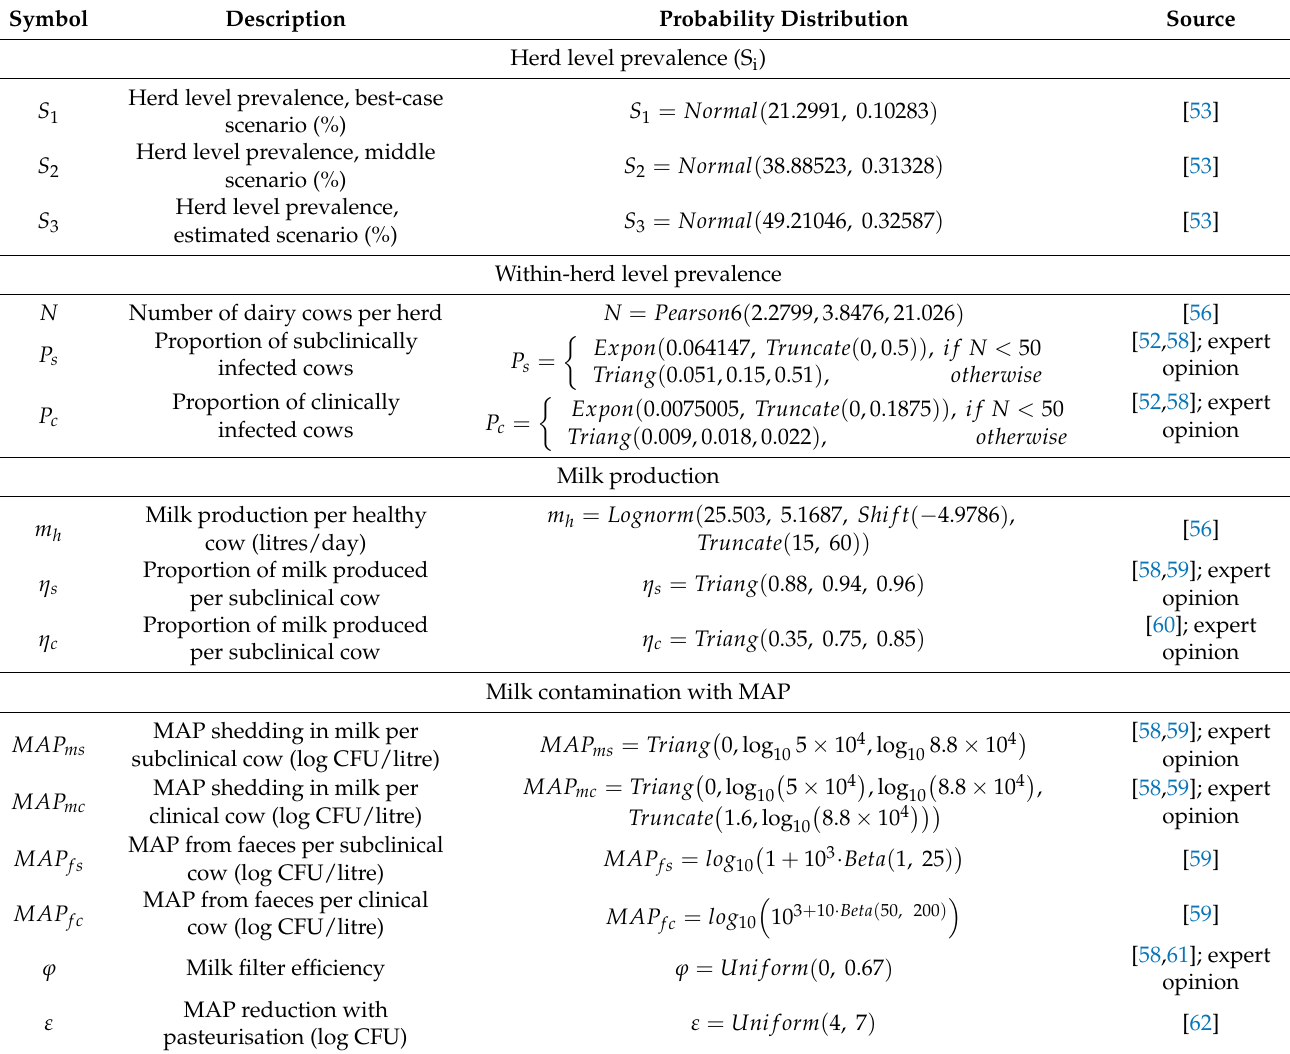
Table 1. Probability distributions of the input variables used in the model to assess human exposure to Mycobacterium avium subsp. paratuberculosis (MAP) from different types of